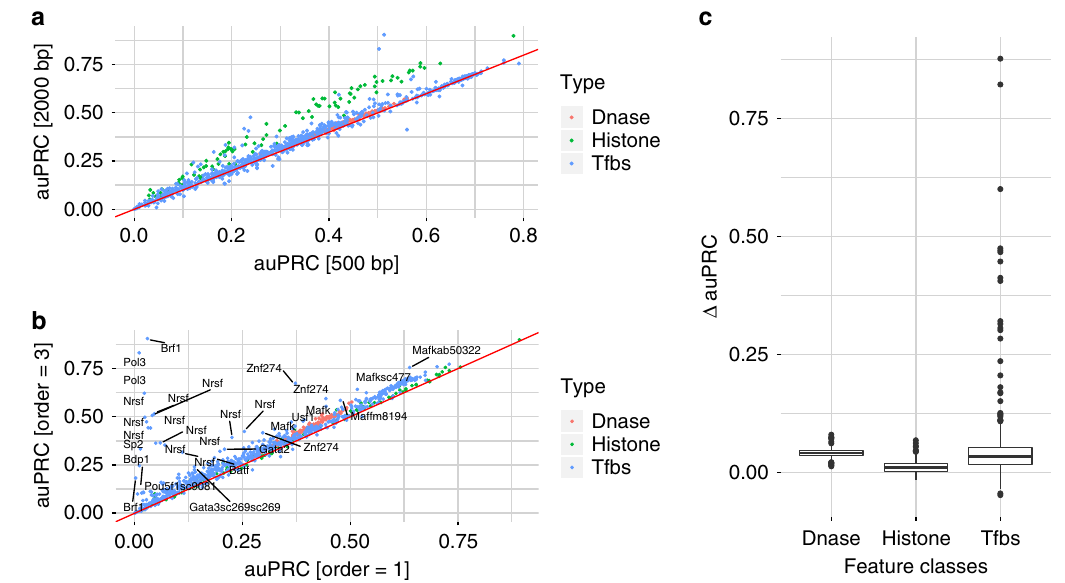
Fig. 3 Comparison of DanQ model variants. a auPRC comparison for the context window sizes 500 bp and 2000 bp for tri-nucleotide based sequence encoding. The mark color indicates the feature types: DNase hypersensitive sites, histone modi fi cations and transcription factor binding assays. b auPRC comparison for tri- and mono-nucleotide based sequence encoding for a context window of 2000 bp. Color coding as above. c Differences in auPRC between tri- and mono-nucleotides for DNase accessibility, histone modi fi cations and transcription factor binding, respectively. Δ auPRC > 0 indicates improved performance for the tri-nucleotide based encoding. Dnase, histone modi fi cation and TF features comprise n = 125, n = 104, and n = 690 samples, respectively. Boxes represent quartiles Q1 (25% quantile), Q2 (median), and Q3 (75% quantile); whiskers comprise data points that are within 1.5 x IQR (inter-quartile region) of the boxes. Table 1 Average Pearson ’ s correlation across the cross- validation runs. Model DNA order Mean Stand. error Pearson ’ s corr.